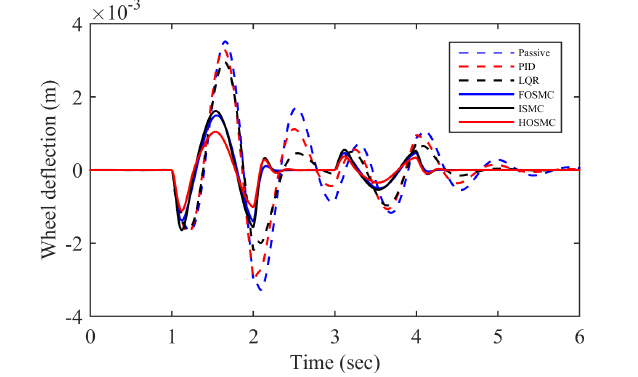
Figure 9. Wheel deflection.